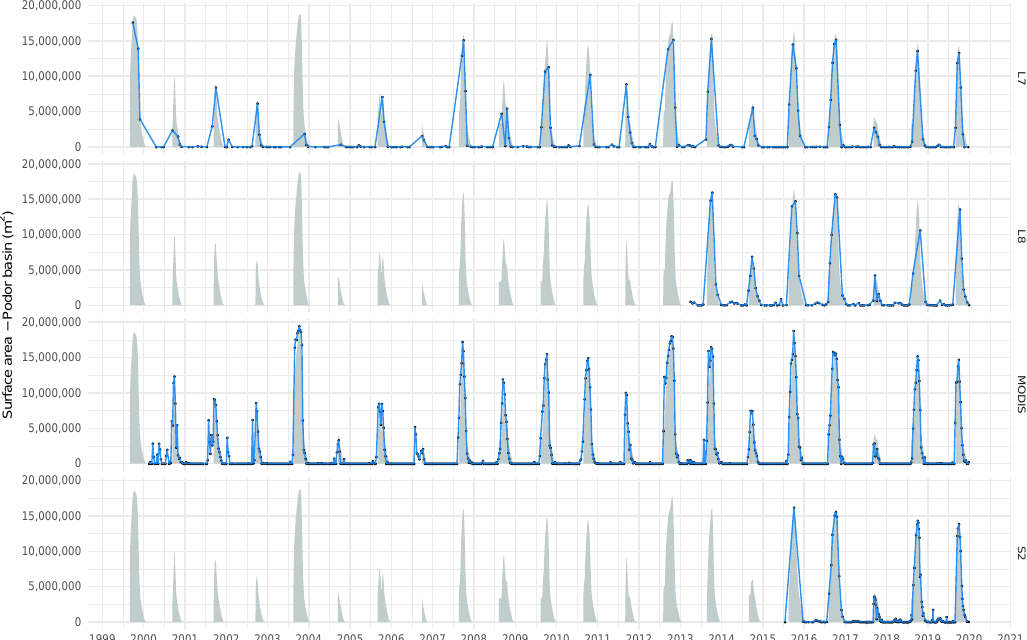
Figure 12. Comparison of remotely sensed flooded areas for each sensor with the optimal MNDWI classification method (blue lines) against ground truth data (grey areas) (1999–2019).